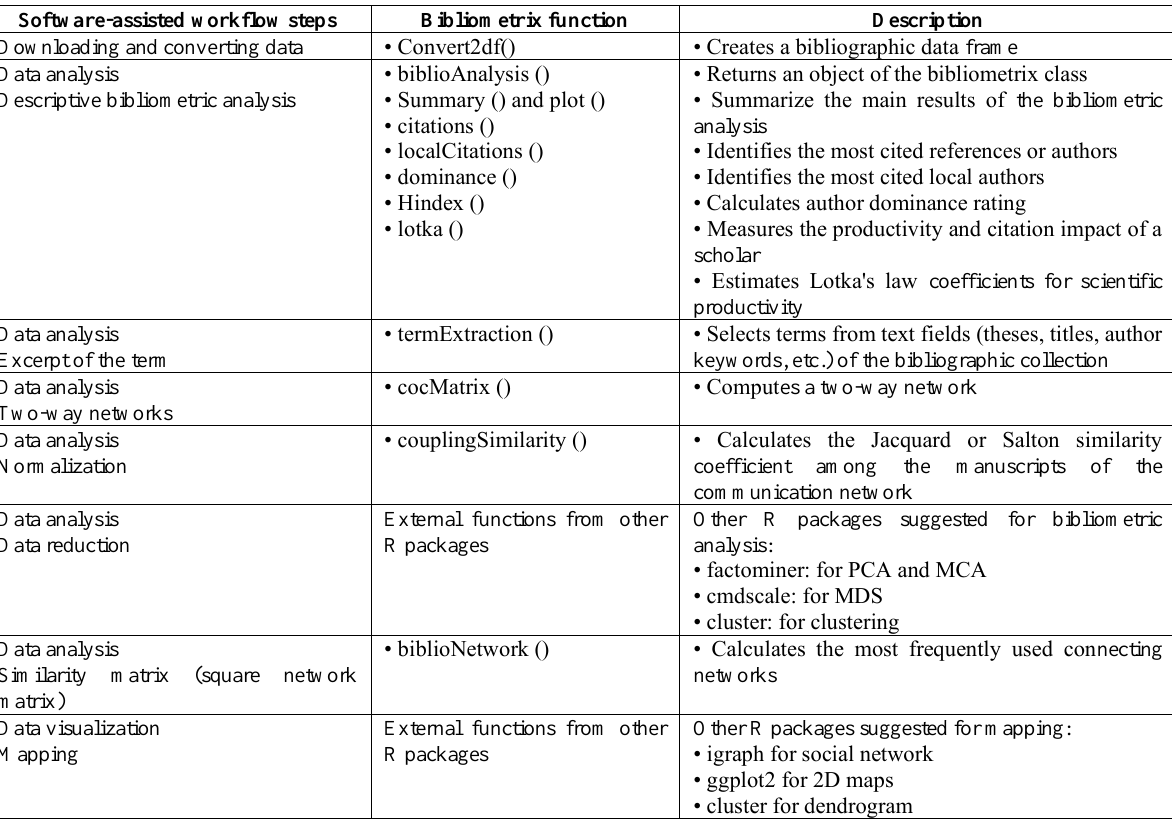
Table 1. Main Functions of the Bibliometrix